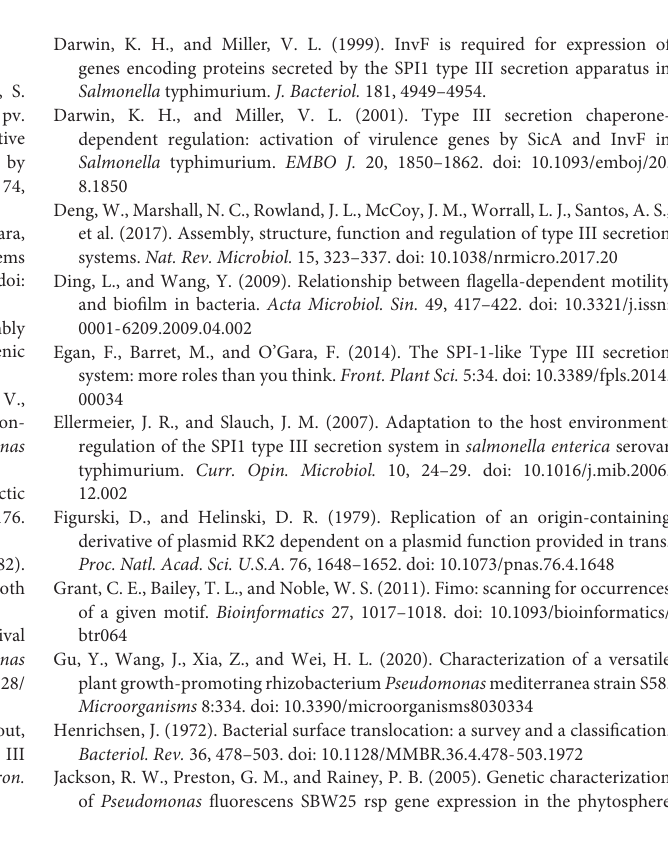
Supplementary Figure 1 | KEGG pathway analyses of DEGs of 2P24 (cid:49) invF that compared with strain 2P24 at 6 h (A) and 12 h (B) after being incubated in MG medium.